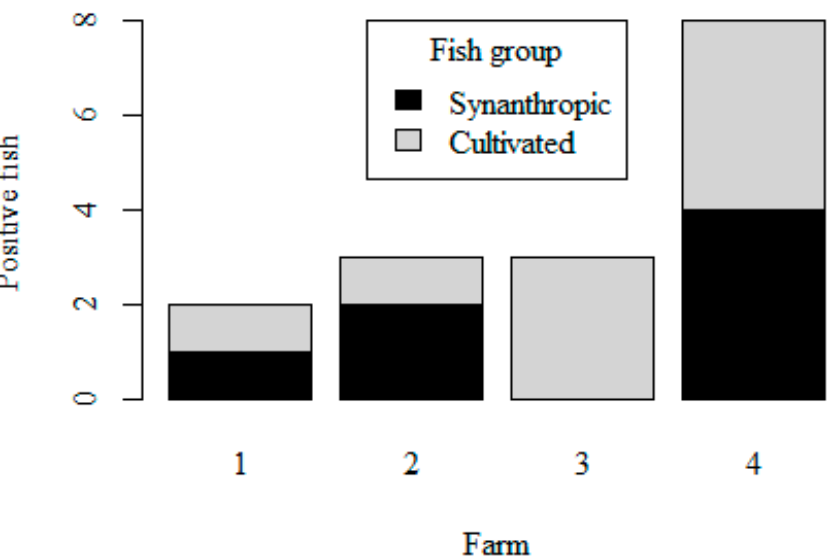
Figure 1. Number of positive fishes according to group and location (only applied to Farms).